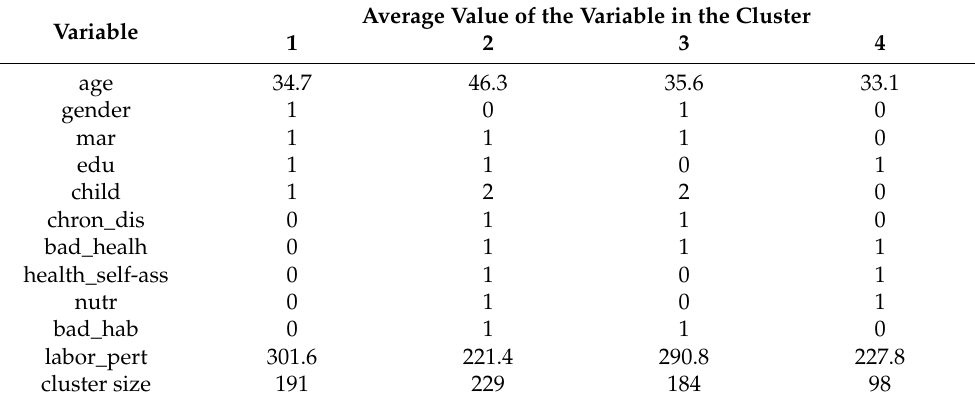
Table 5. Clusters’ centers ( K -means